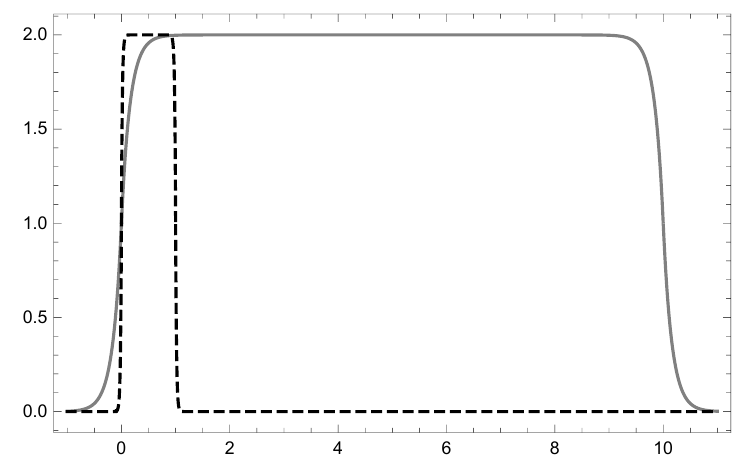
Figure 2 . Analysis of f ( x ) for large values of a=(cid:12) . For a (cid:12)xed large value of a=(cid:12) (in this case, a=(cid:12) = 10) the graph of the function f tends to the square barrier sgn( x ) (cid:0) sgn( x (cid:0) a ) and has a sharp slope at the points x = 0 and x = a . Dotted line corresponds to a = 1, full line to a = 10. Analysis of the